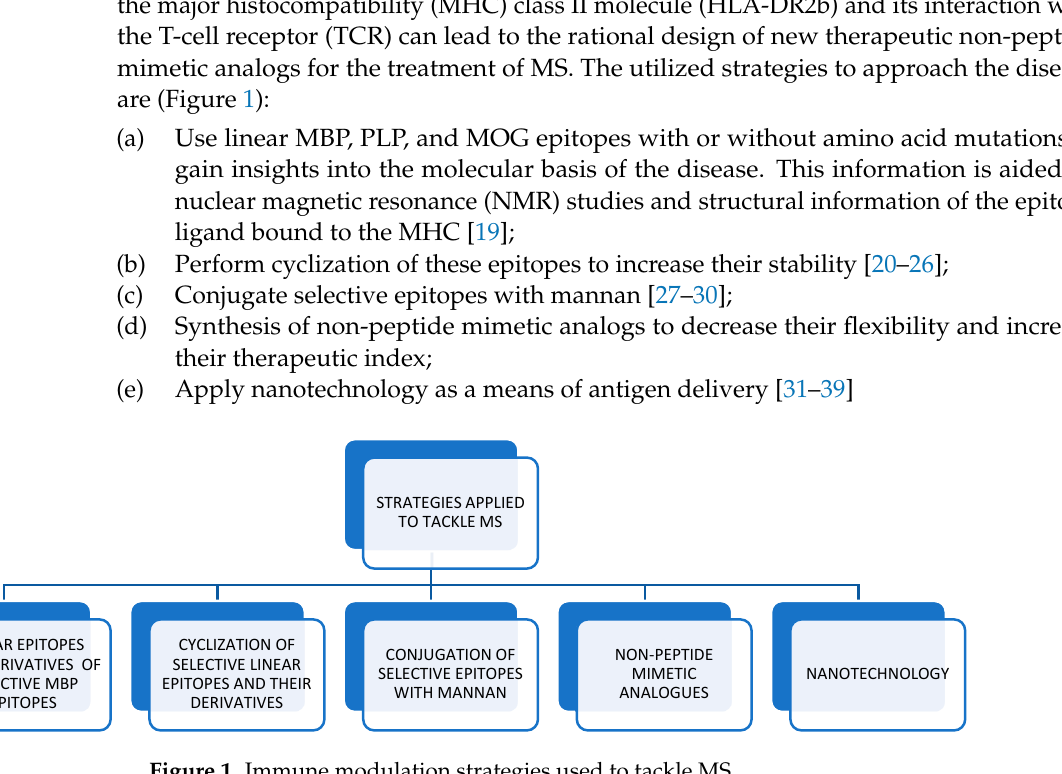
Figure 1. Immune modulation strategies used to tackle MS.